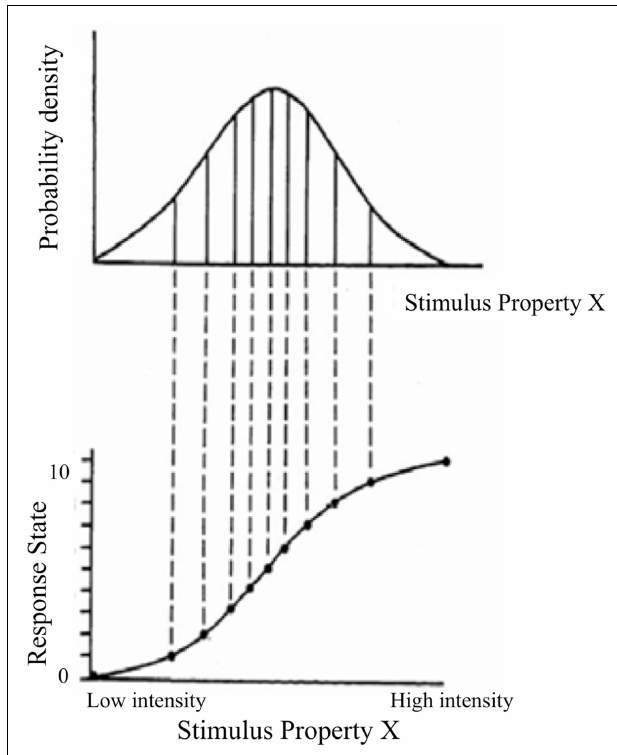
FIGURE 6 | Illustration of information maximization principle. Adapted from Laughlin (1981).